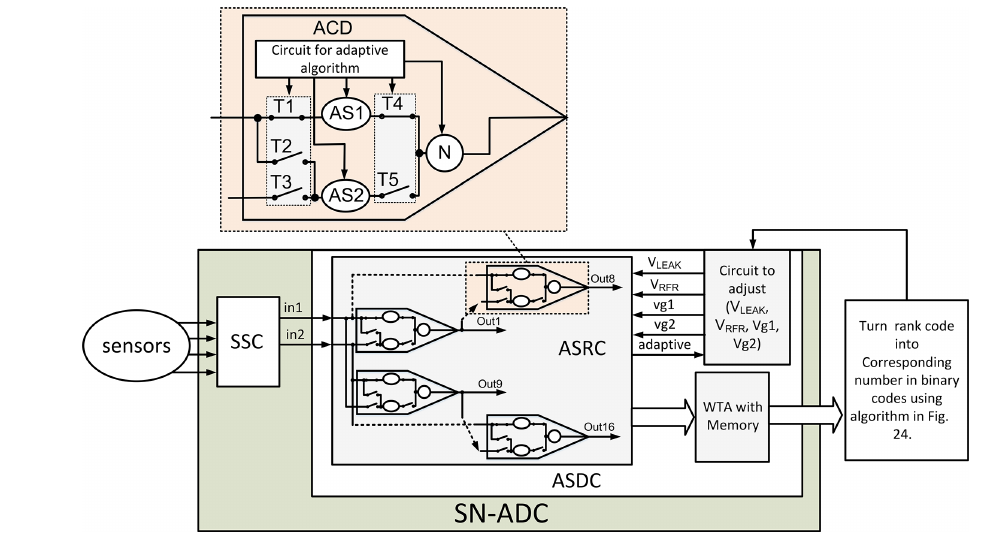
Figure 7. Neuromorphic signal conditioning architecture. The spiking neural analog-to-digital data conversion (SN-ADC) has a two- part sensor-to-spike converter (SSC) and adaptive spike-to-digital converter (ASDC). The ASDC consists of adaptive spike-to-rank cod- ing (ASRC), a winner-take-all (WTA) circuit with memory, and a circuit to control the variables V LEAK , V RFR , vg1, and vg2. The ASRC has 16 adaptive coincidence detections (ACDs), and every ACD has two adaptive synapses (ASs) and one neuron (N), as well as a circuit for the adaptive